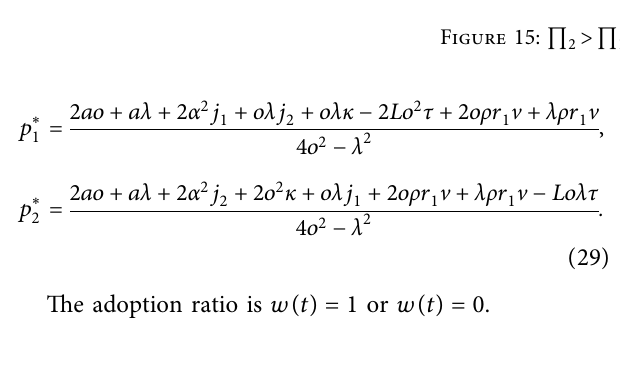
> 􏽑 in equilibrium 2 1